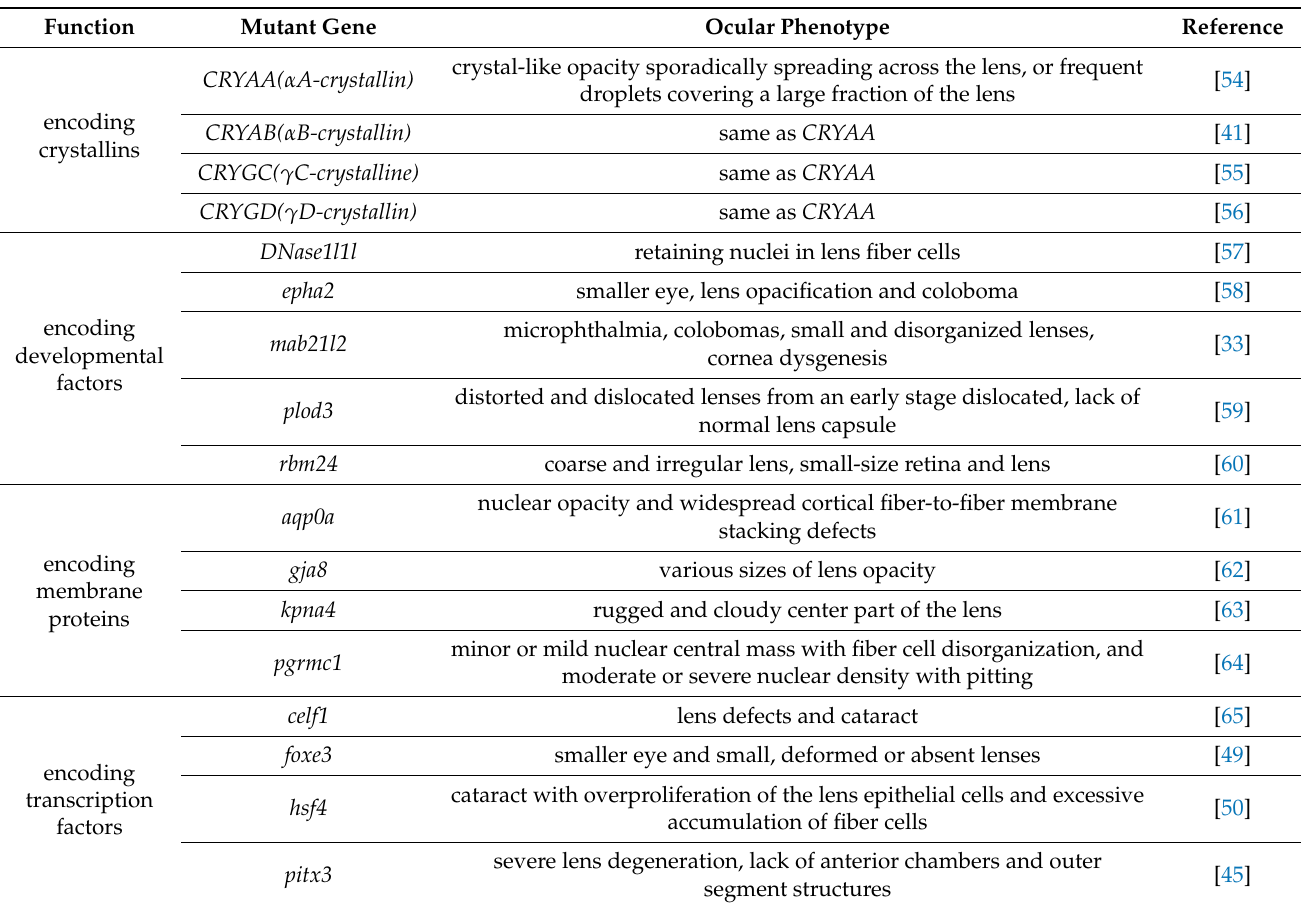
Table 1. Genetic mutations of zebrafish models for congenital